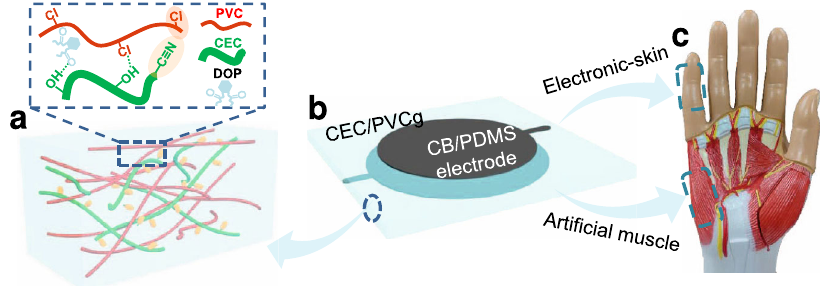
Fig. 1 | Schematic illumination of CEC/PVCg matrix for actuation and sensing applications. a The high permittivity of CEC/PVCg is granted by strong orienta- tional polarization of C ≡ N dipole moments and giant charge accumulation at het- erogeneous interfaces. The low viscoelasticity of CEC/PVCg is resulted from the multiple molecular interactions, including the H-bonding and electrostatic